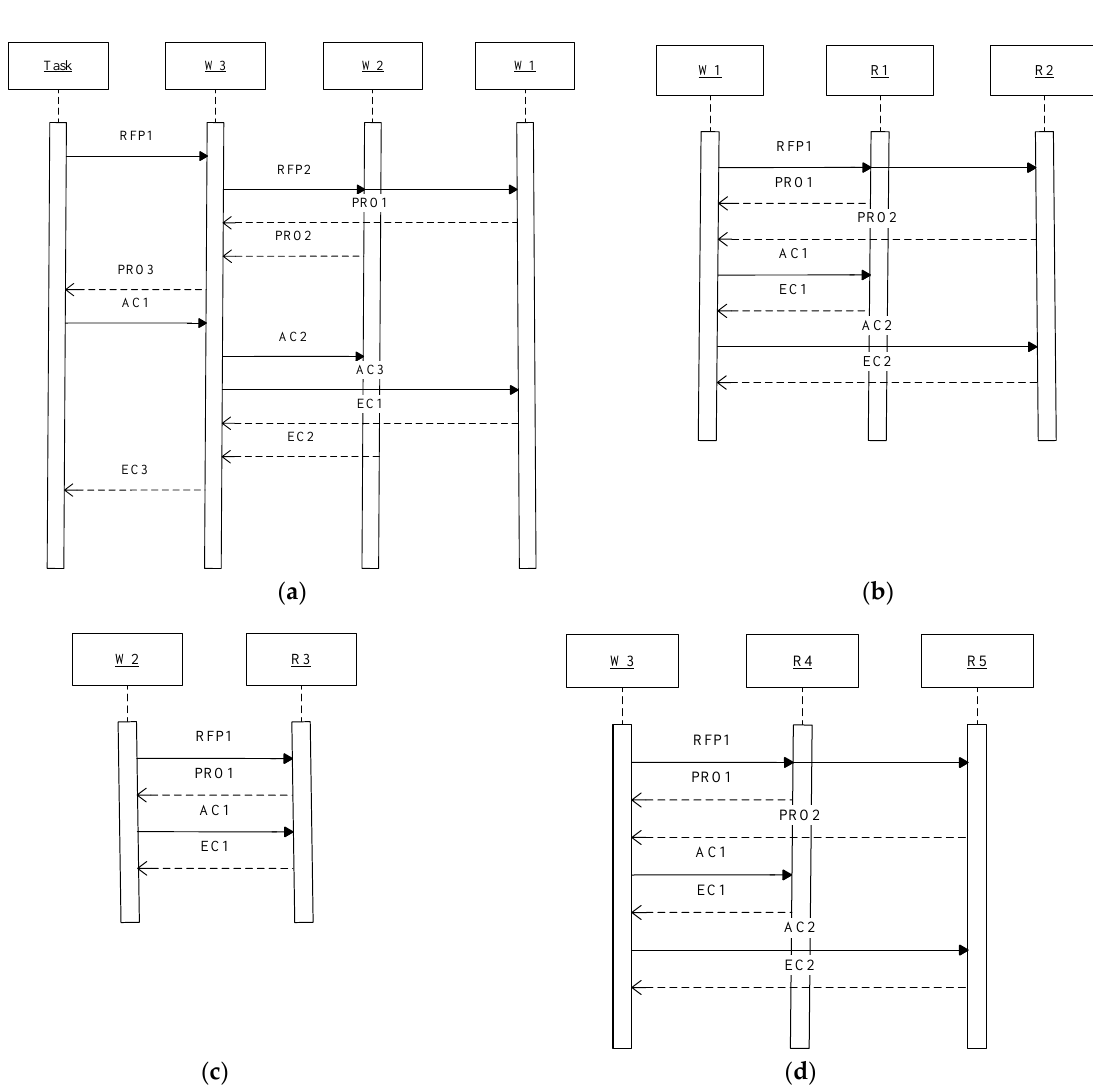
Figure 5. ( a ) Interactions between the task agent and process agents. ( b ) Interactions between process agent W 1 and resource agents R 1 and R 2. ( c ) Interactions between process agent W 2 and resource agent R 3. ( d ) Interactions between process agent W 3 and resource agents R 4 and R